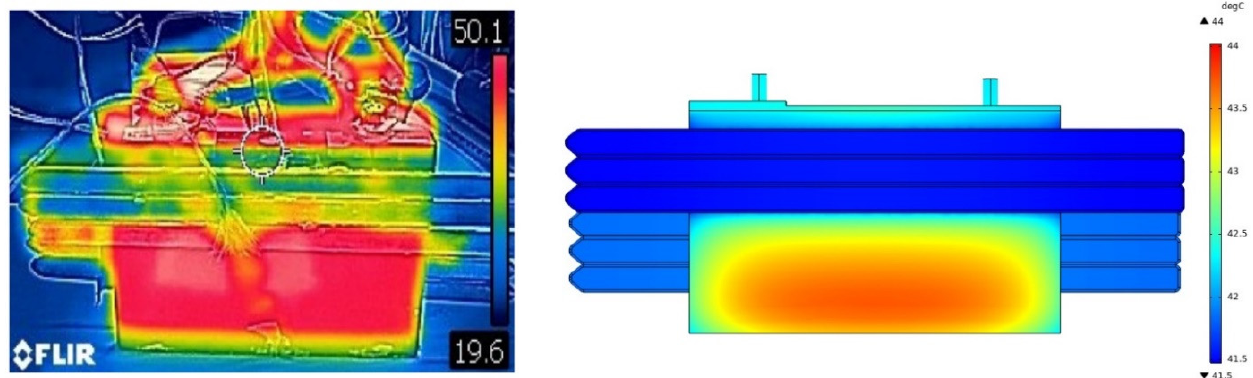
Figure 12. The experimental results taken by the thermal camera ( left ) and the numerical simulation by COMSOL Multiphysics [66].